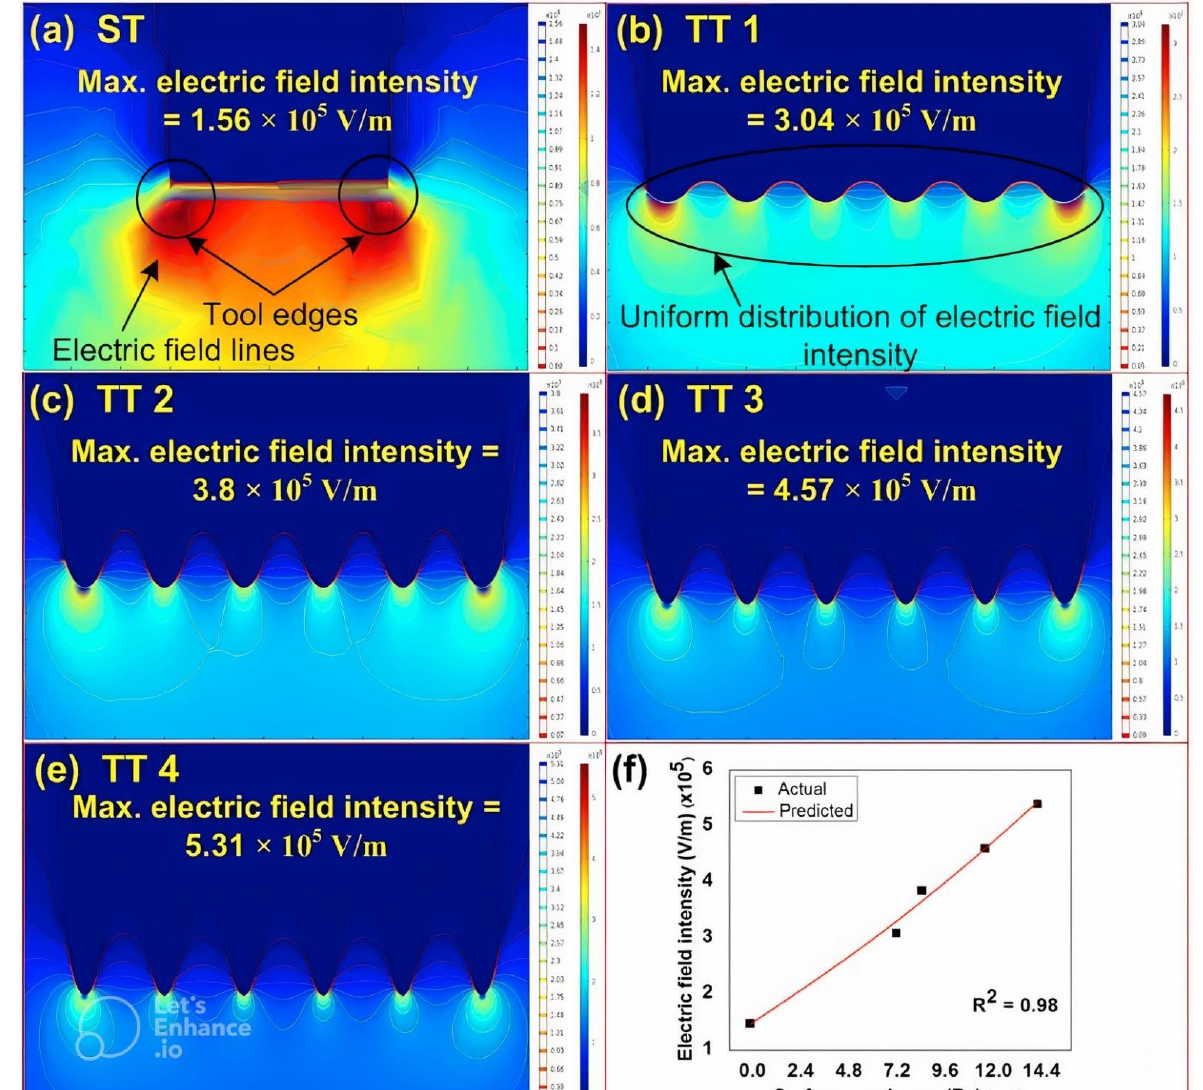
Figure 7. Effect of topography of tool electrode on electric field intensity ( a ) smooth tool, ( b – e ) tool with different roughness values, and ( f ) effect of surface roughness on electric field intensity. Materials 2022 , 15 , x FOR PEER REVIEW